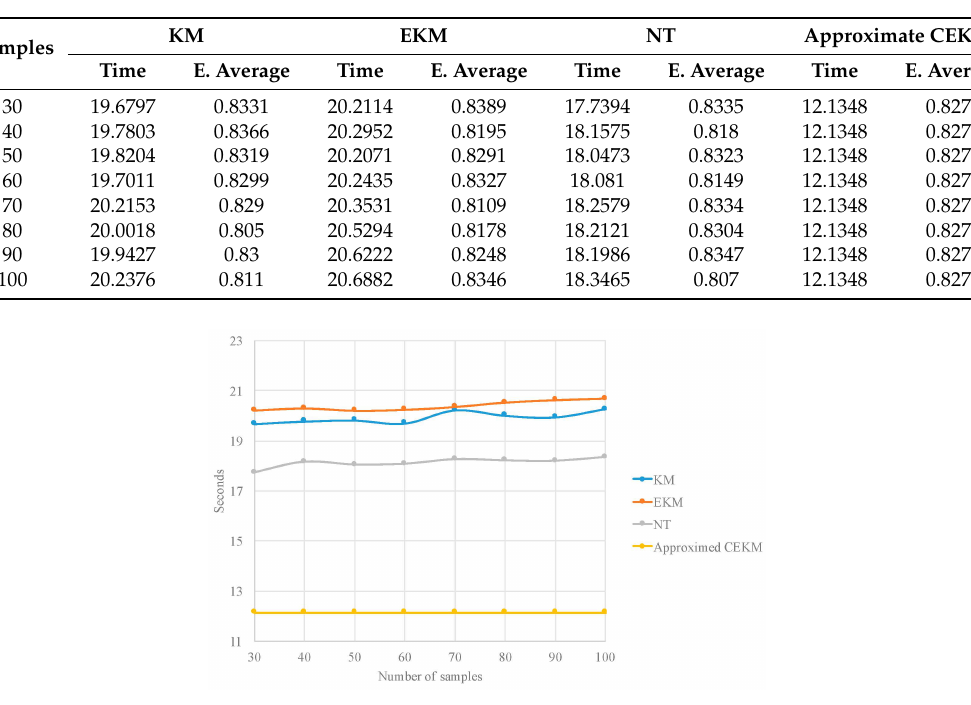
Figure 14. Execution time comparison for different type-reduction methods. Algorithms 2017 , 10 , 77